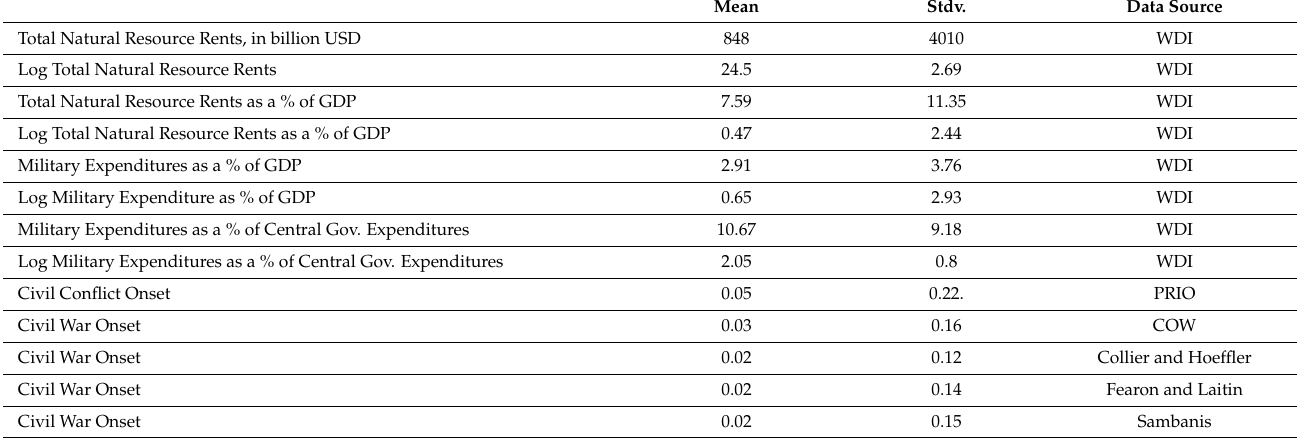
Table A1. Summary